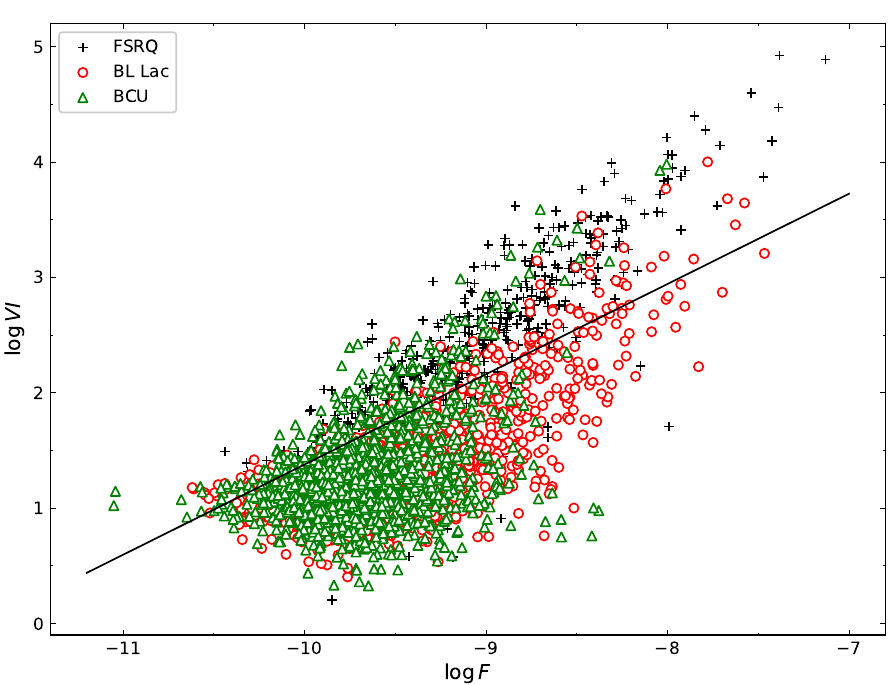
Figure 5. Plot of variability index (log VI ) against gamma-ray photon flux (log F ). Open circles stand for BL Lacs, plus for FSRQs and triangle points for BCUs. The solid line (log VI = 0.792log F + 9.203) is obtained from the SVM method; it separates FSRQs and BL